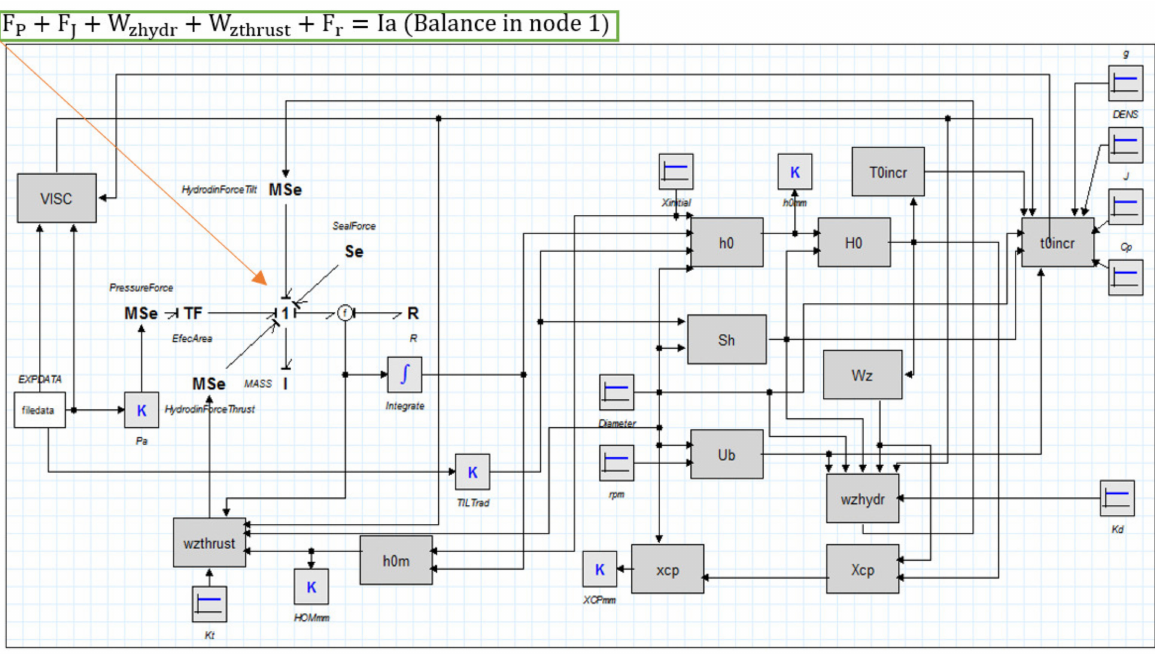
Figure 6. Bond graph of the floating bushing